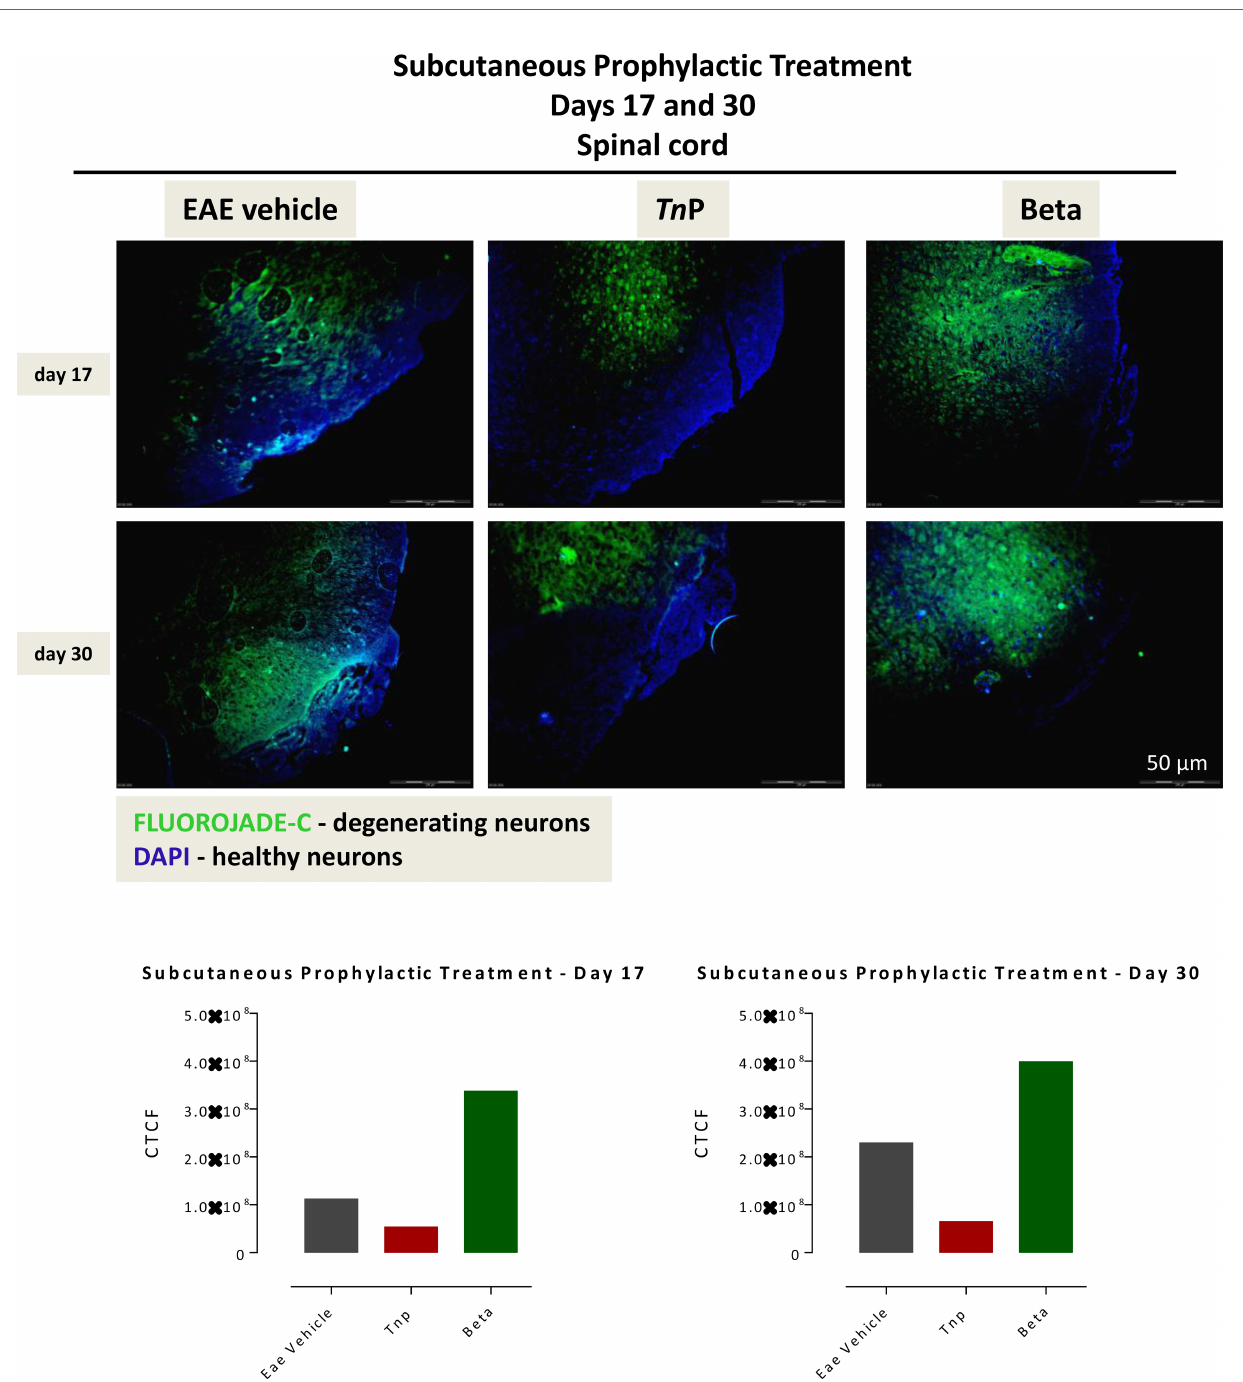
FIGURE 2 | Subcutaneously Tn P treatment promotes the long-lasting survival of neurons in spinal cord. The 10 micron-thick slices of spinal cord of vehicle-treated EAE or Tn P- and betaseron-treated EAE mice removed at day 17 or 30 were prepared for immuno fl uorescent double-staining with Fluoro-Jade C (green) and DAPI (blue) for evaluation the degree of neurodegeneration in damage areas. Representative sections are shown. The fl uorescence staining was measured in ImageJ Software v.1.8.0_172. The corrected total cell fl uorescence (CTCF) was obtained utilizing the formula CTCF = Integrated Density – (Area of selected cell X Mean fl uorescence of background